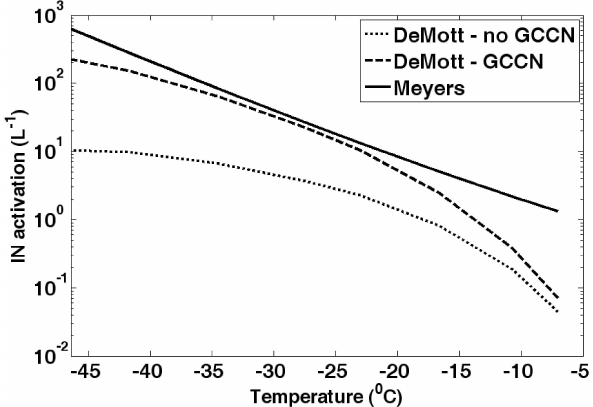
Fig. 8. Comparison between the formation rate (liter − 1 ) of ice crys- tals by ice nucleation through deposition and condensation freez- ing between two parameterizations – Meyers et al. (1992) and De- Mott et al. (2010). Aerosol size distribution was taken from Levin et al. (2005) and supersaturation above water was assumed as 1%.